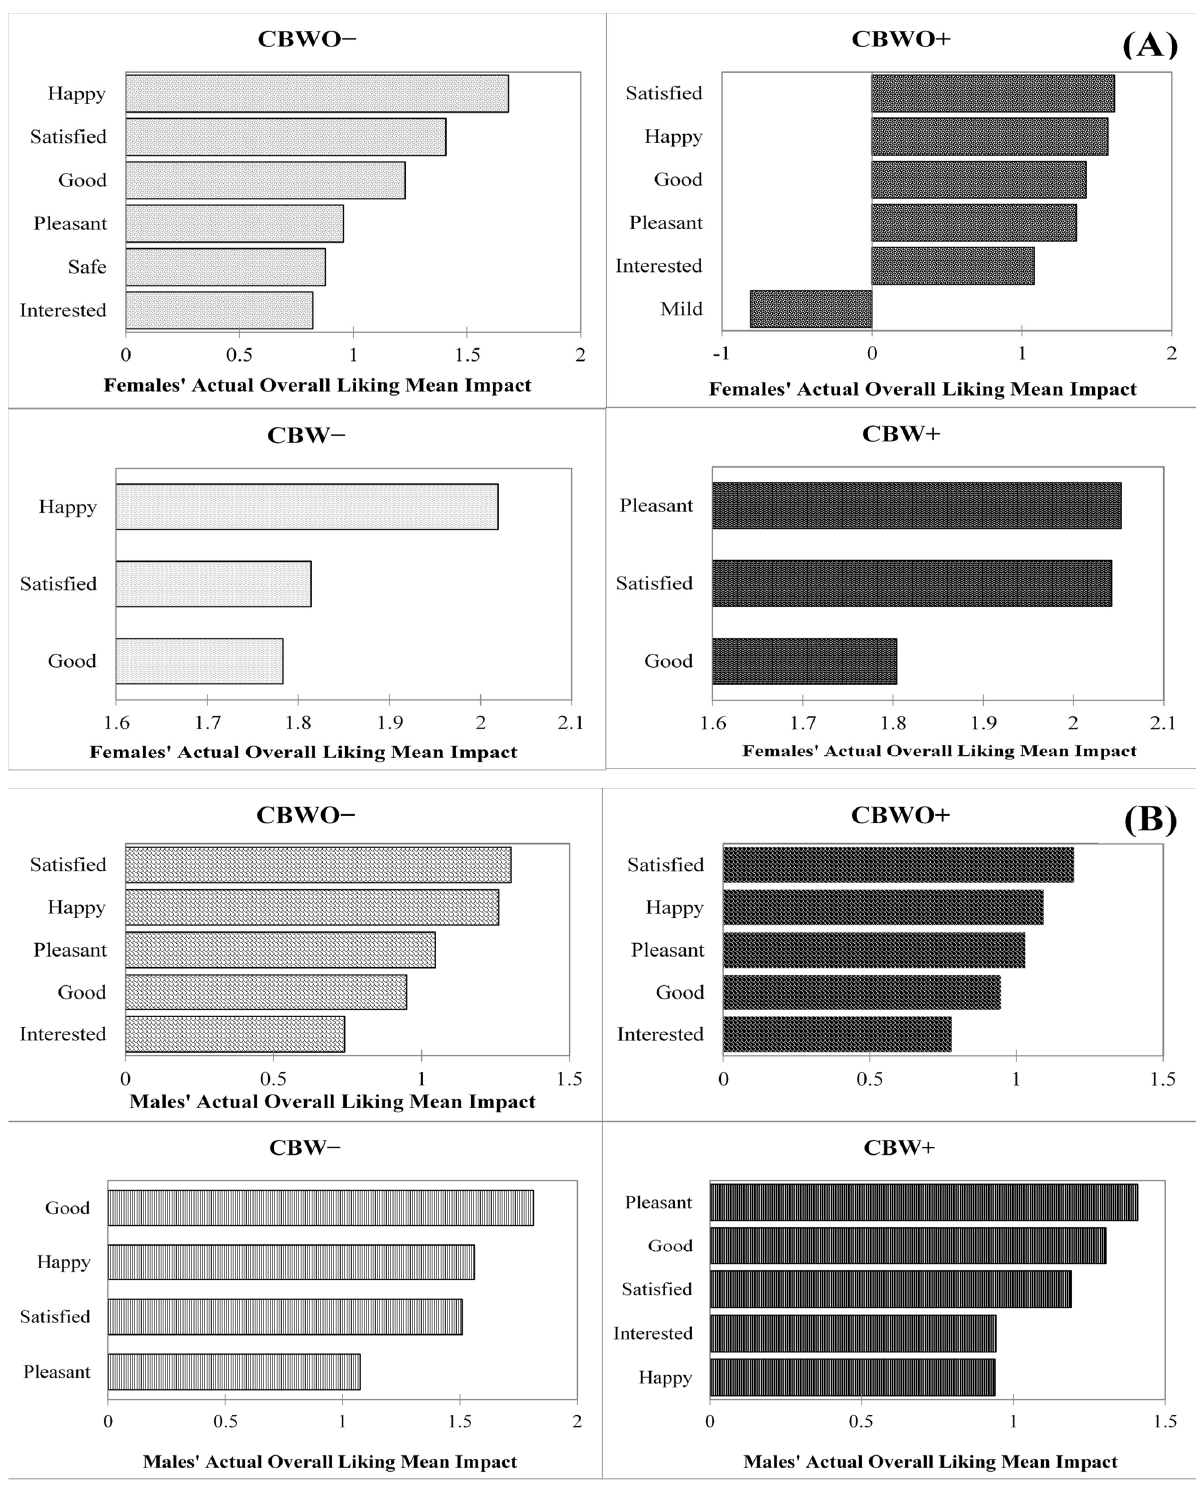
Figure 6. Treatments after-tasting overall liking (OL) mean impact (mean OL difference from present vs. absent categories for each emotion with a 20% population threshold size) vs. significant ( p < 0.05, 2-sample t -test) emotions in the after-tasting condition (%) for ( A ) female ( n = 112) and ( B ) male ( n = 98) groups. Treatments are described in Figure 1.